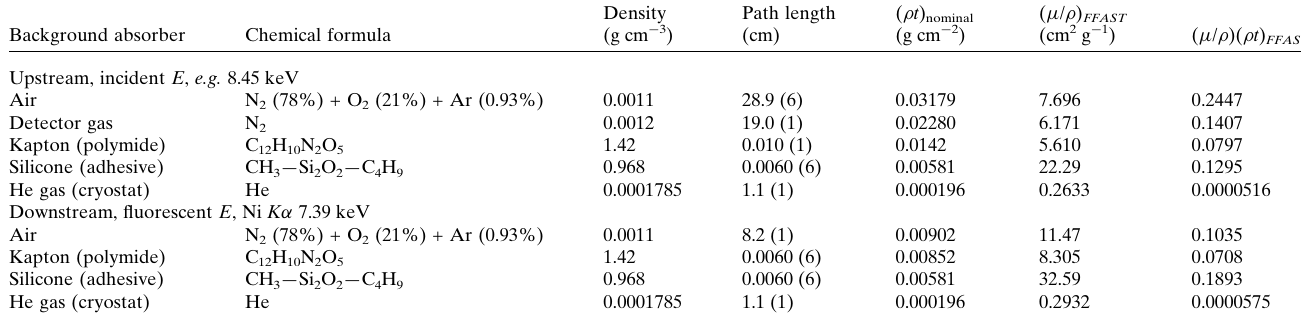
Table 1 Estimated attenuation contributions by the background absorbers using FFAST theoretical data of X-ray mass attenuation coefficients, and the geometry of the experimental setup. For fluorescence geometry one needs to separate the incident flux at incident energy through the upstream path lengths, from the fluorescent emission path lengths, hence the parameters displayed in the table. The path lengths were determined from the measured geometry of the experimental set-up. Background